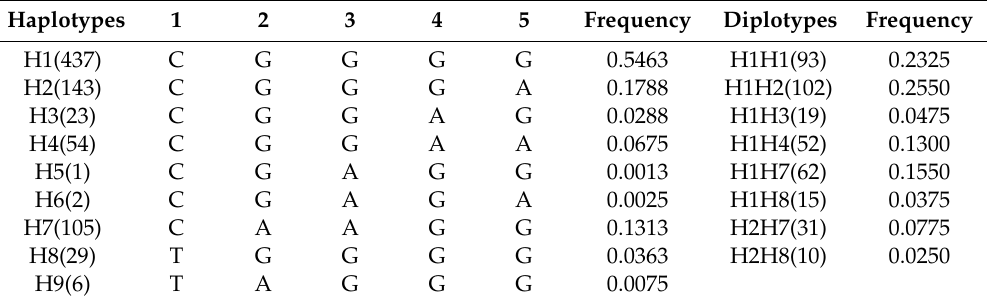
Figure 3. Analysis of blocks with 11 SNPs in the PITX2 gene in Wuliang Mountain Black-bone chickens. The values in the squares indicate the paired linkage disequilibrium ( LD ) values ( D’ ) of the SNPs. When D’ = 1, the values will not be displayed. The redder the square, the stronger the LD . The haplotype block was defined using the default setting of the Haploview software. Table 4. Haplotypes and diplotypes based on the block 1 and frequencies in Wuliang Mountain Black- bone chickens.